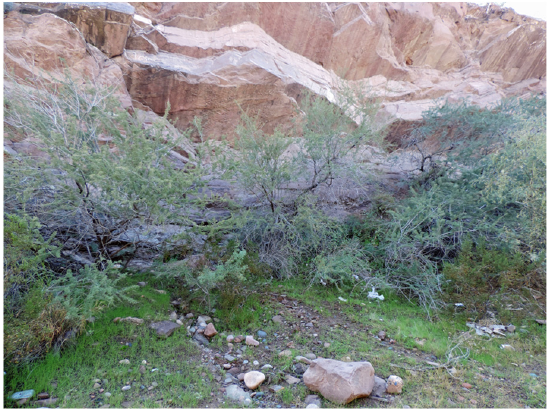
Figure 11. Tempe, Arizona WMP riparian setting.